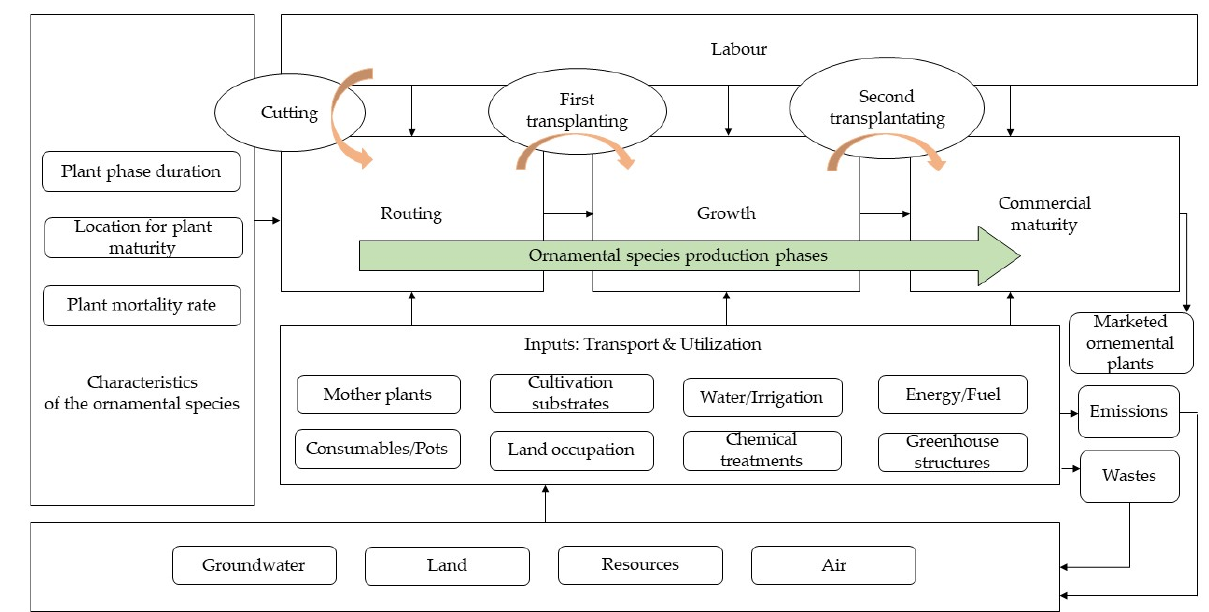
Figure 2. Flows of information used for our life cycle inventory for which the greenhouse structures were excluded owing to their minimal significance for the goals of this research.